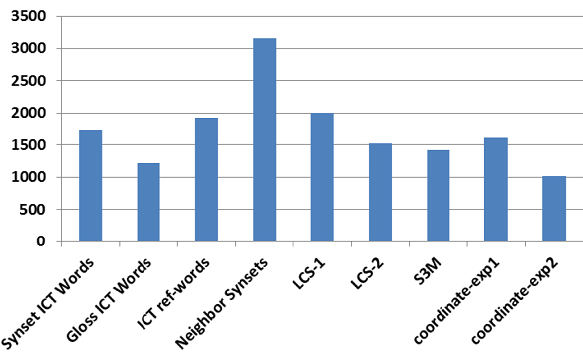
Figure 4. # of ICT synsets extracted by each